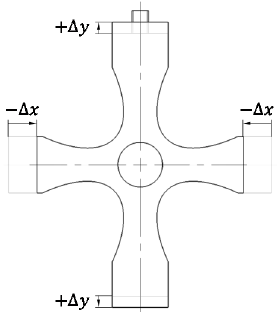
Figure 19. Result from the “change in arms’ dimensions” method to obtain an out-of-phase C-T specimen with a non-unitary biaxiality ratio at 20 kHz [26].